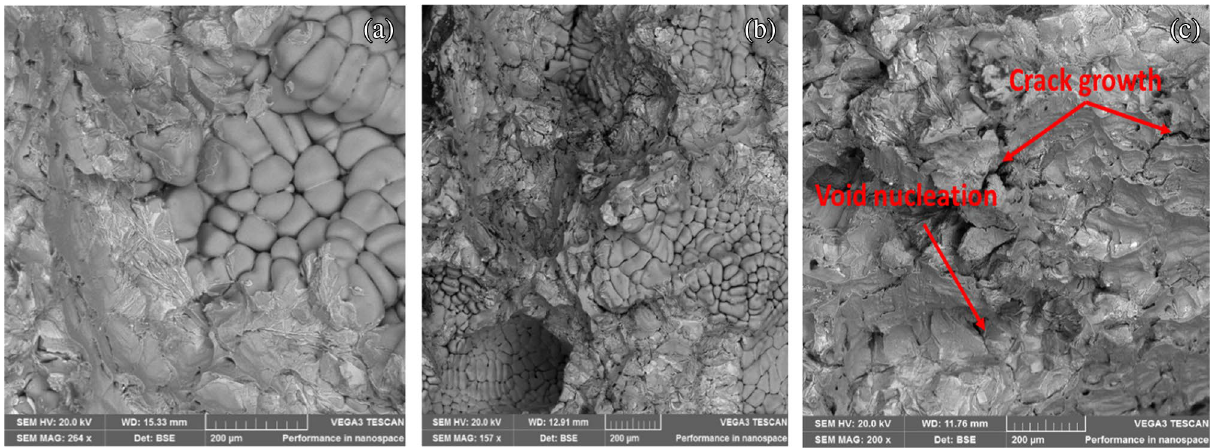
Figure 13. Fractured surface micrograph for ( a ) Unreinforced matrix, ( b ) reinforced composite (A1), ( c ) reinforced composite